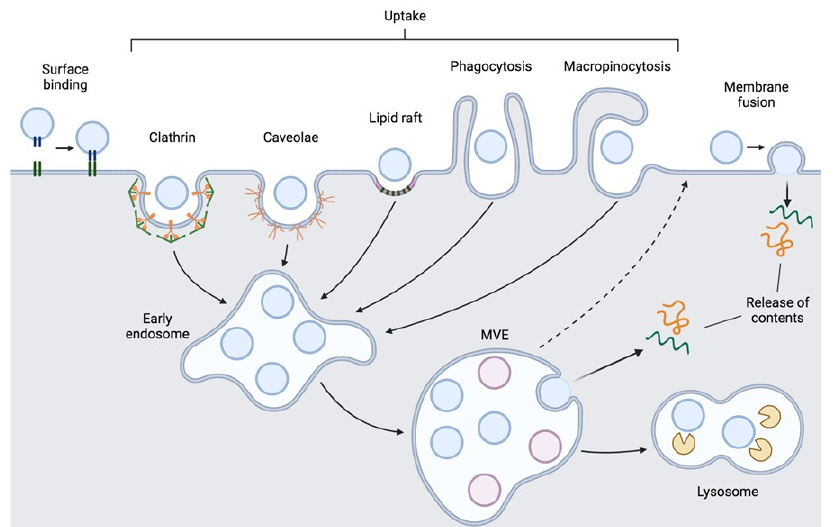
Figure 2. Interaction of extracellular vesicles (EVs) with recipient cells. EVs bind to the surface of recipient cells in a process that can be mediated by several molecules, being able to elicit functional changes without entering the cell. EVs may also be internalized by recipient cells through different uptake routes, which include clathrin- or caveolin-mediated endocytosis, endocytosis mediated by lipid rafts, phagocytosis or macropinocytosis. Internalized vesicles follow the endosomal pathway, being sorted into early endosomes and proceeding to MVE. Then, EVs can follow different routes: they can be recycled back to the plasma membrane and released; EVs can fuse with the limiting membrane of MVE releasing their contents to the cytoplasm of the recipient cell; or MVE may fuse with lysosomes leading to EV degradation. In alternative to EV uptake, EVs may also fuse directly with the plasma membrane of the recipient cell, releasing their cargo directly into the cytosol. MVE — multivesicular endosomes. Figure created with BioRender.com.